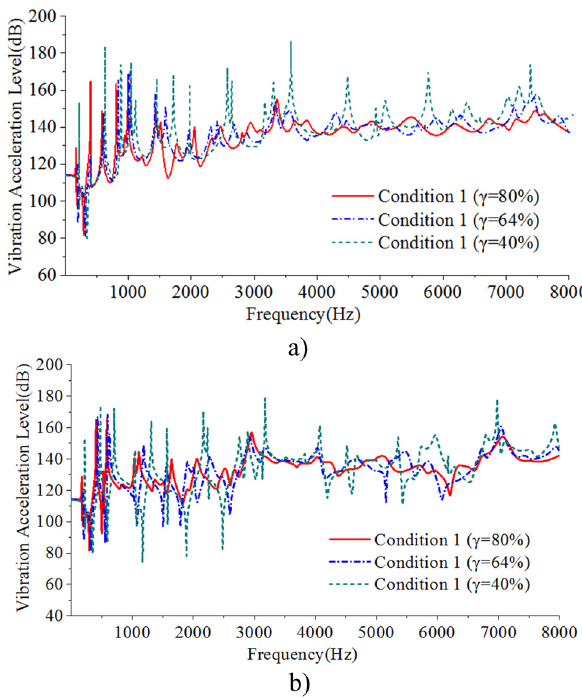
Figure 10: Vibration response curve of each working condition assessment point: ( a ) average vibration response of P 1 – P 5 and ( b ) average vibration response of P